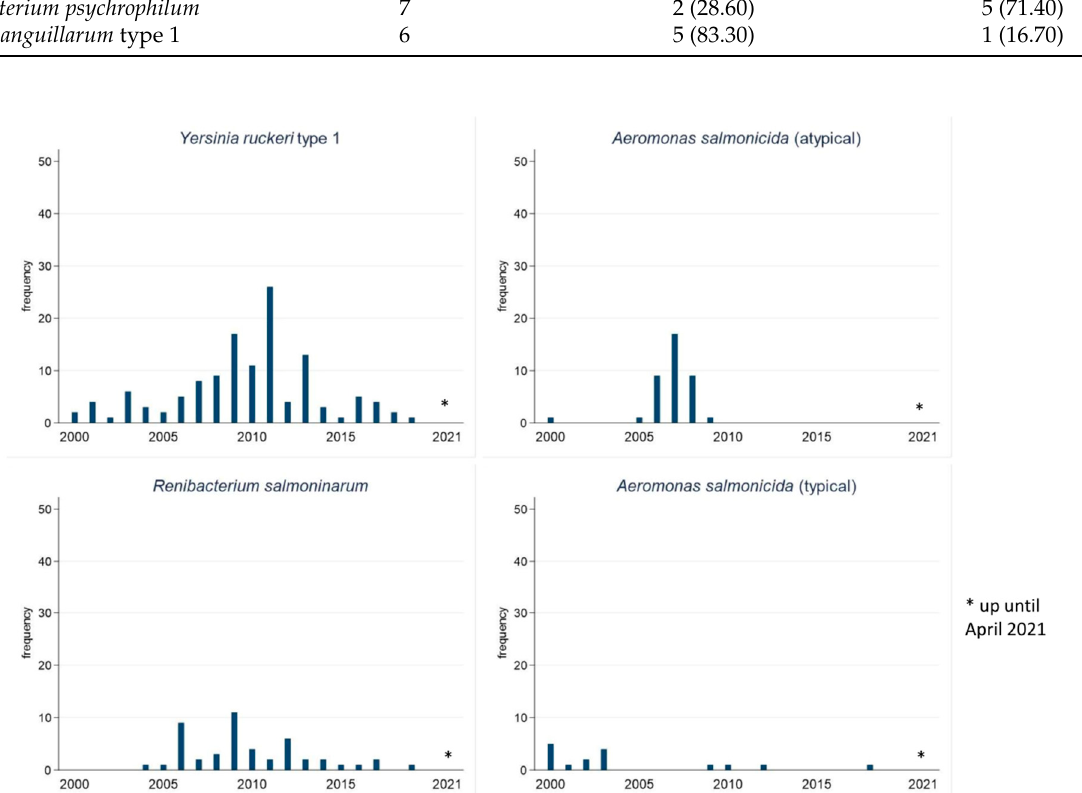
Figure 4. Annual frequency of Yersinia ruckeri type 1, Renibacterium salmoninarum , Aeromonas salmonicida (typical), and Aeromonas salmonicida (atypical) detected from salmonid cases submitted to AVC ADSBL (2000–2021). Table 1. Frequency of bacterial isolates detected in submitted cases to the AVC ADSBL by species of salmonid samples (2000–2021).